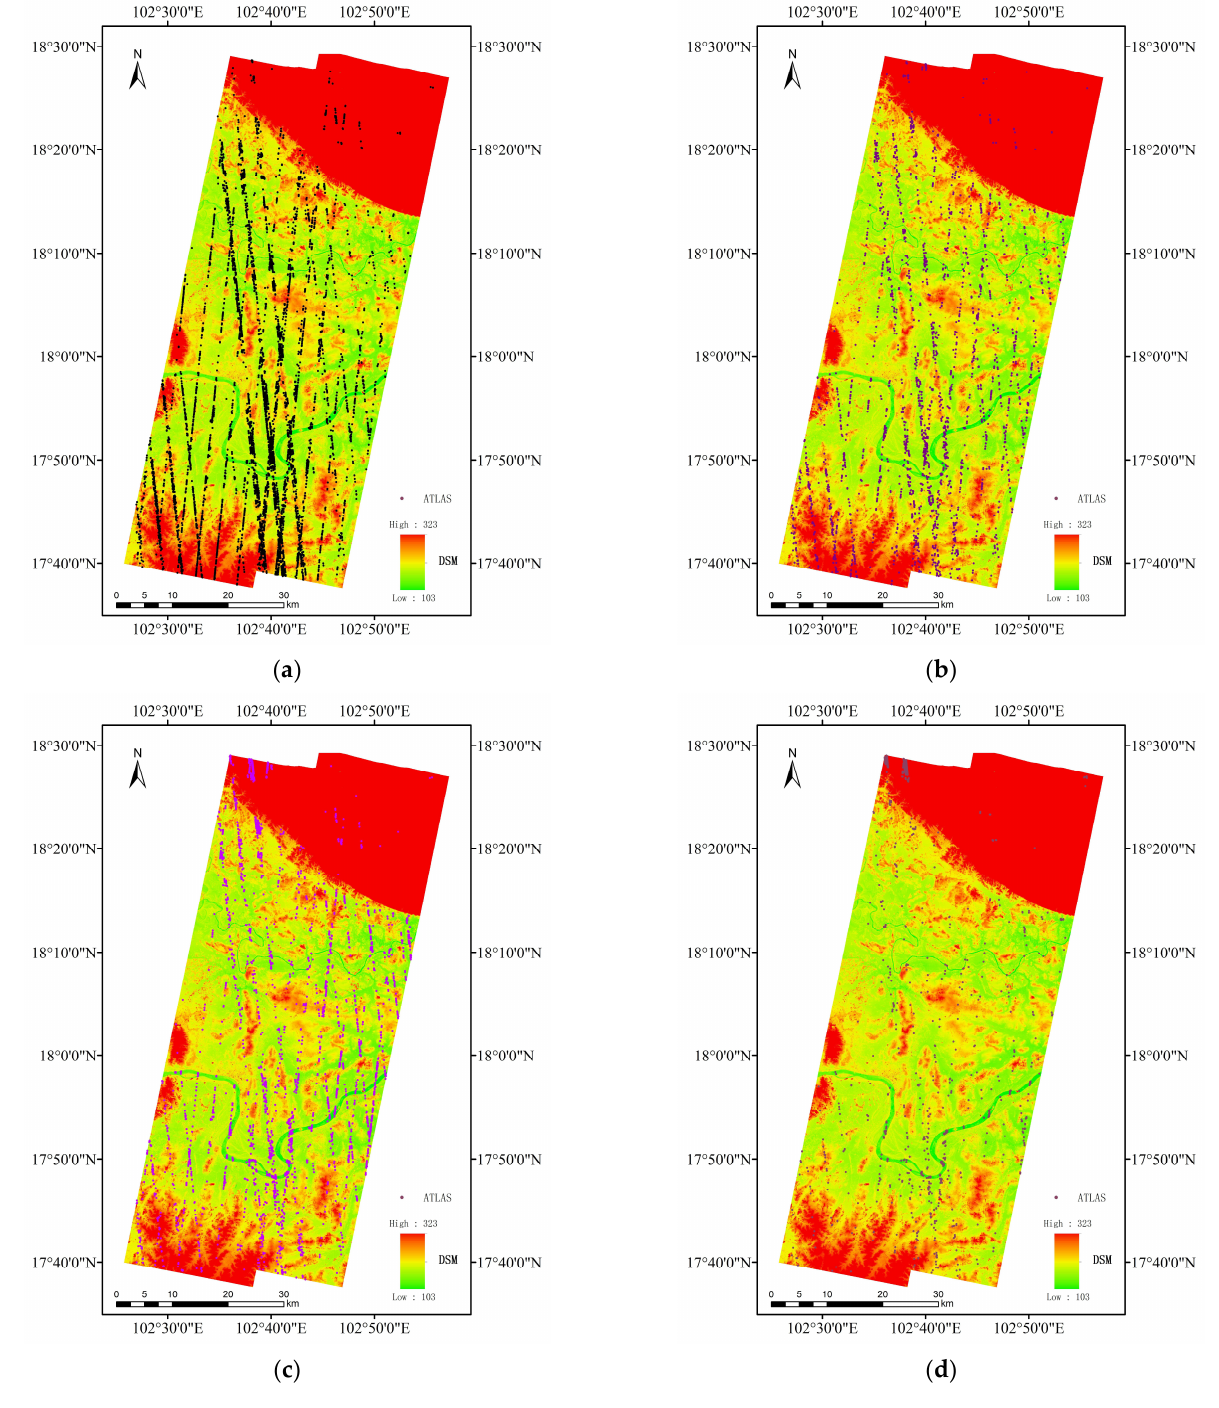
Figure 12. Distribution of extracted ATLAS LPs with different height discrepancies. ( a ) Less than 1.0 m, ( b ) between 1.0 m and 1.5 m, ( c ) between 1.5 and 3.0 m, ( d ) over 3.0 m.